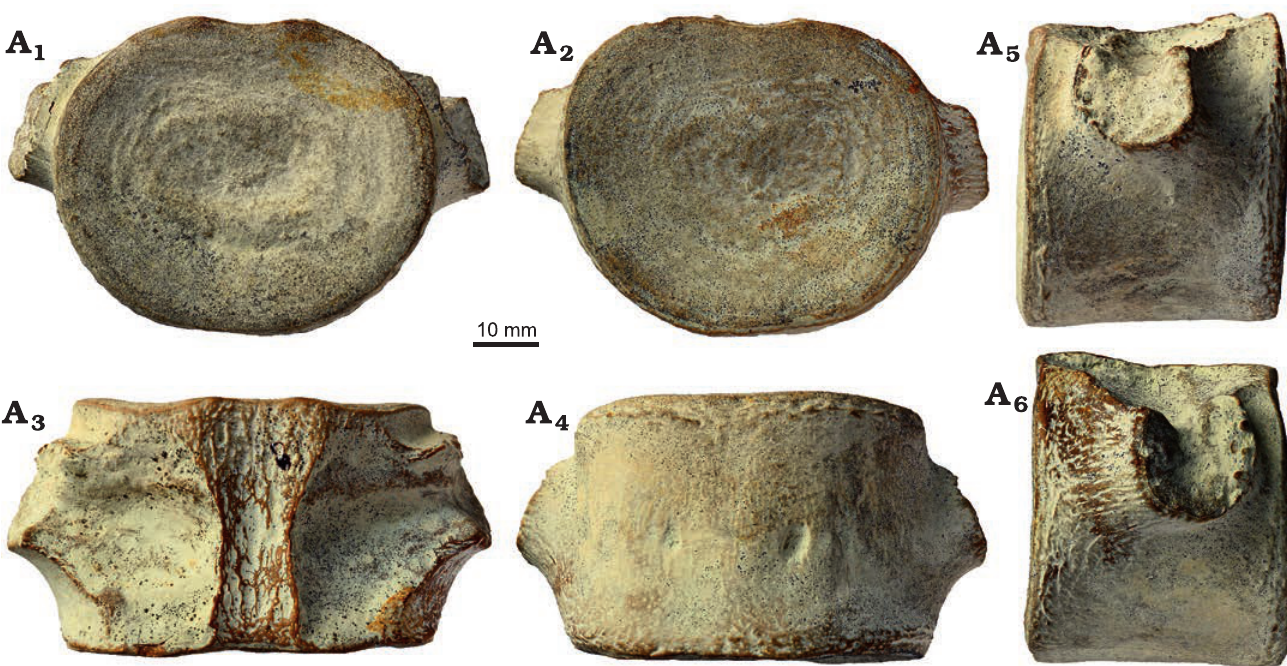
Material .—MZ VIII Vr-73 (“ZPAL V-KRZ/32”) (see above with respect to the ambiguity regarding the catalogue number of the specimen), a pectoral vertebral centrum reported by Tyborowski and Błażejowski (2019a) as originating from the light yellow marl, upper Kimmeridgian of Krzyżanowice, Poland (Dąbrowska 1957; Borsuk-Biały nicka and Młynarski 1968). Tybo rowski and Błażejowski (2019a, b) reported an iso - lated plesiosaur pectoral centrum (MZ VIII Vr-73 or “ZPAL V-KRZ/32”), though their taxonomic interpretation of the